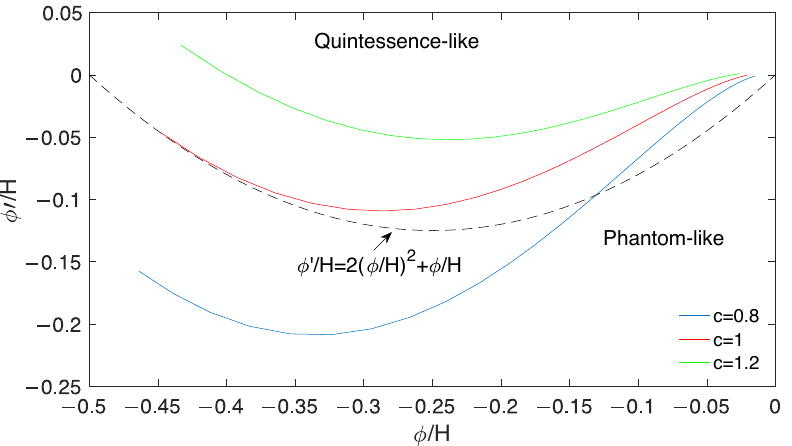
Figure 3. The dimensionless ratio φ (cid:48) / H as a function of φ / H .